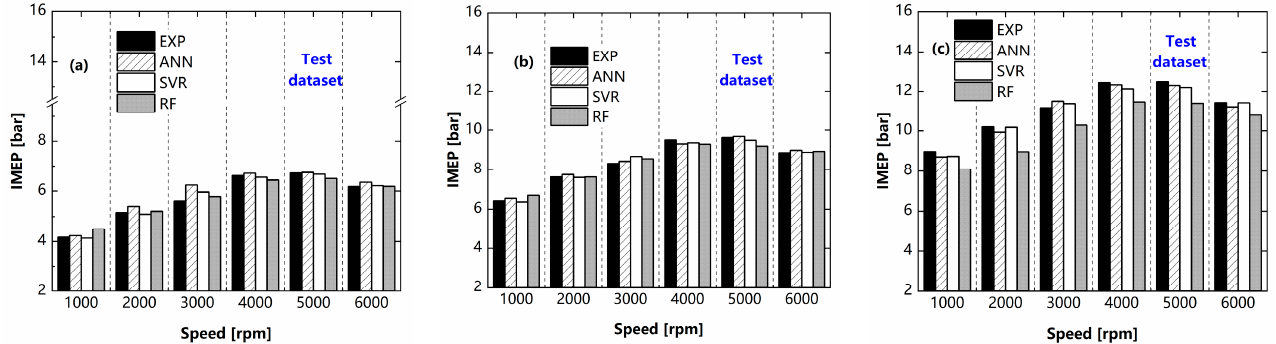
Figure 10. Comparison of predicted IMEP with actual values at MBT: ( a ) low load; ( b ) medium load; ( c ) high load.